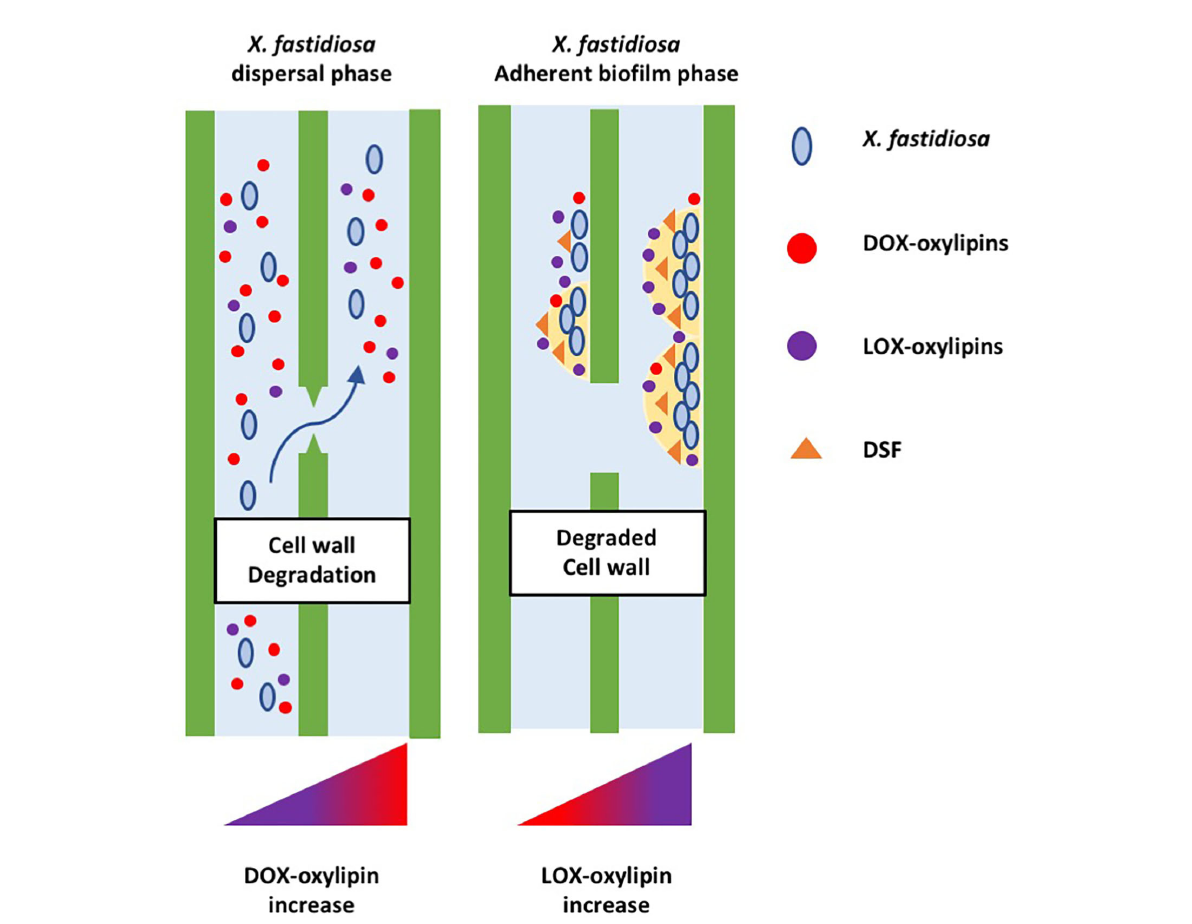
FIGURE3 Hypothetical model involving oxylipins as signals in X. fastidiosa– host interaction. At the begin of host–bacteria interaction, the host does not recognize the presence of the pathogen, the bacterium modulates the planktonic-biofilm by itself, thought DFS-QS and ODS, and accumulates mainly DOX-oxylipins. Later, the plant recognizes the pathogen, activates the defense response, and triggers plant LOX-oxylipins. The bacterial pathogen switches in the “acquisition phase” by DSF-QS and ODS, accumulating mainly LOX-oxylipins. The bacterium–host interaction stimulates the bacteria biofilming, vector acquisition, and extensive vascular blockage plants, favored by a LOX oxylipins pathway in response to as an adaptive strategy to cope with harsh environmental conditions and to establish pathogenic insult with their